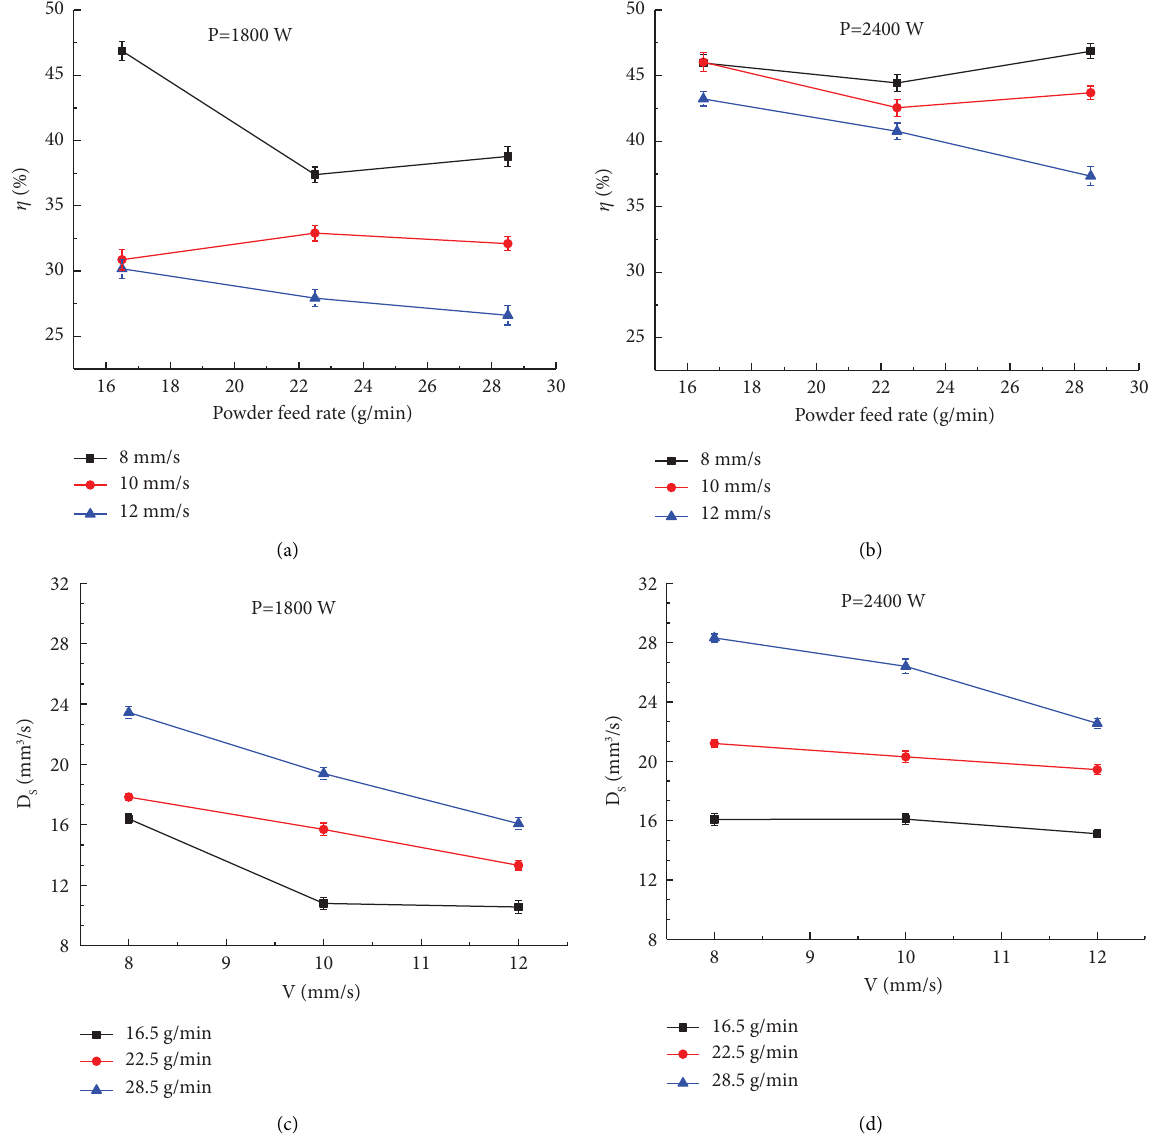
Figure 10: Efect of process parameters on powder efciency ( η ) and deposition speed ( D at a constant power